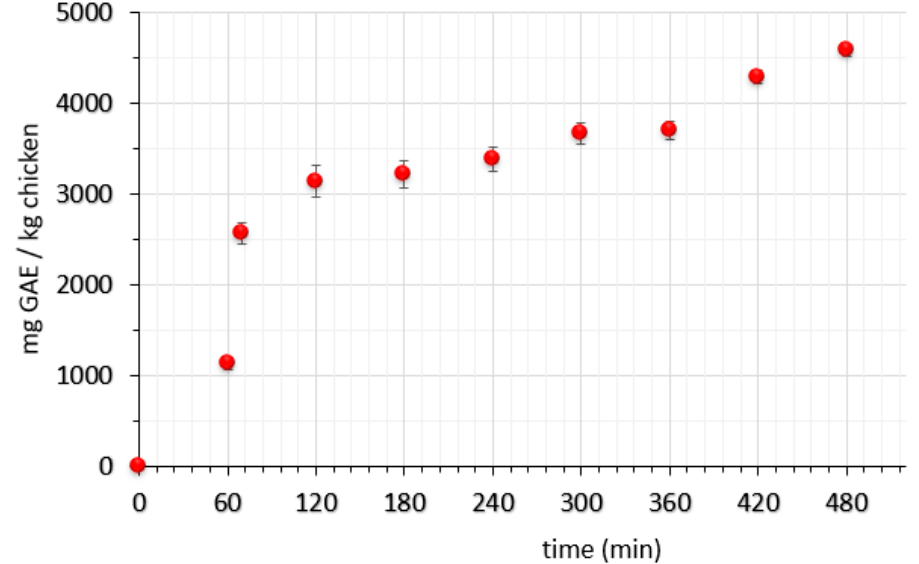
Figure 1. Impregnation of phenolics into chicken muscle, expressed as mg GAE/kg of chicken muscle (OV/OD procedure). Error bars represent the ± standard deviation of multiple measurements.